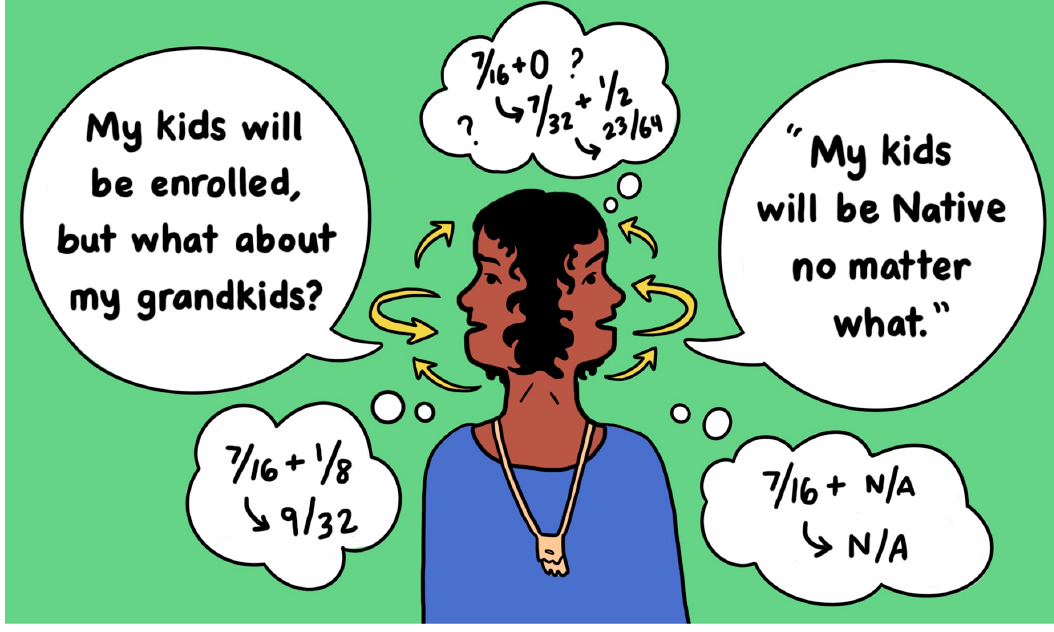
Figure 11. A woman is calculating the blood quantum of offspring while her head is turning back and forth between perspectives on identity. See I.D. 11 in Appendix A.